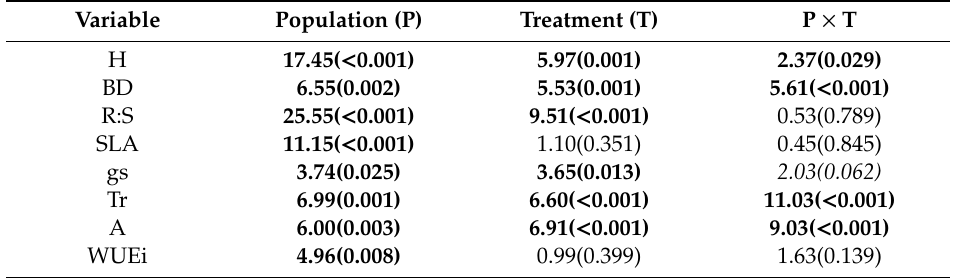
Table 2. Summary statistics of the general linear model and p -values (F) for the e ff ect of the di ff erent populations (Toledo, T; Calderona, C; Espad à , E) and treatments (control, Co; drought, D; MgCO 3 , Mg; and CaCO 3 , Ca) on cork oak ( Quercus suber ) seedling performance. Numbers in bold indicate significant e ff ects ( p < 0.05) and italics denote marginally significant e ff ects (0.05 < p < 0.1). Post hoc results can be found in Figure S2 in the Supplementary